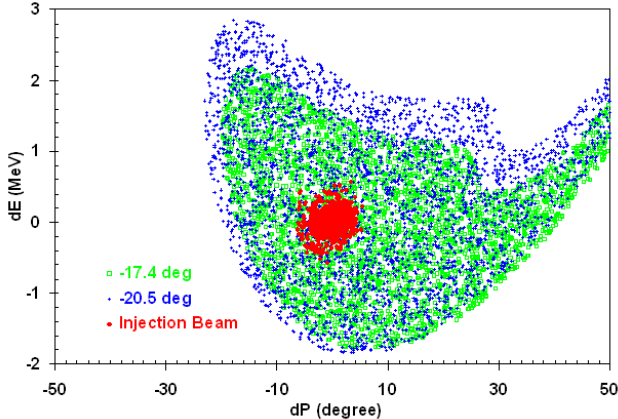
FIG. 1. (Color) Longitudinal acceptance of the SCL with an average synchronous phase of (cid:1) 17 : 4 (cid:3) (green squares) for each medium beta cavity and (cid:1) 20 : 5 (cid:3) (blue dots), an injection beam emittance with tails 6 times greater than the nominal beam is shown (red dots) for